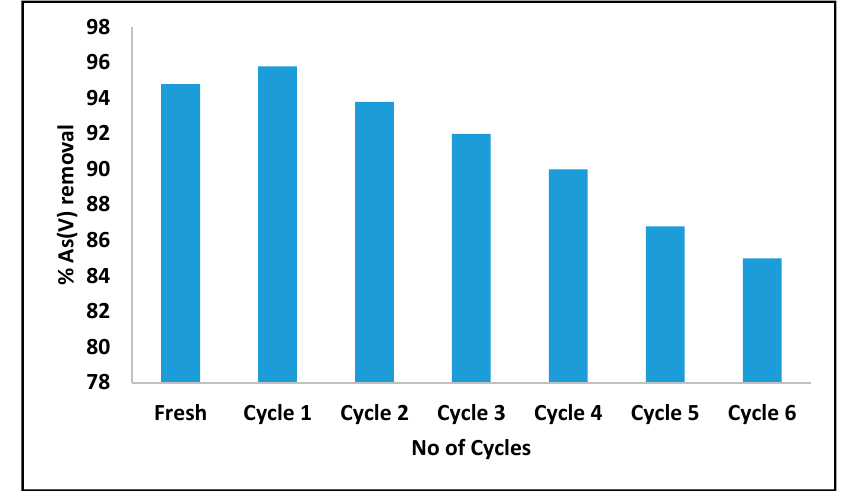
Figure 8. The variation of As(V) removal by FMK as a function of regeneration cycles (5 mg/L As(V), 0.4 g/100 mL adsorbent dosage, 60 min contact time at 250 rpm shaking speed).